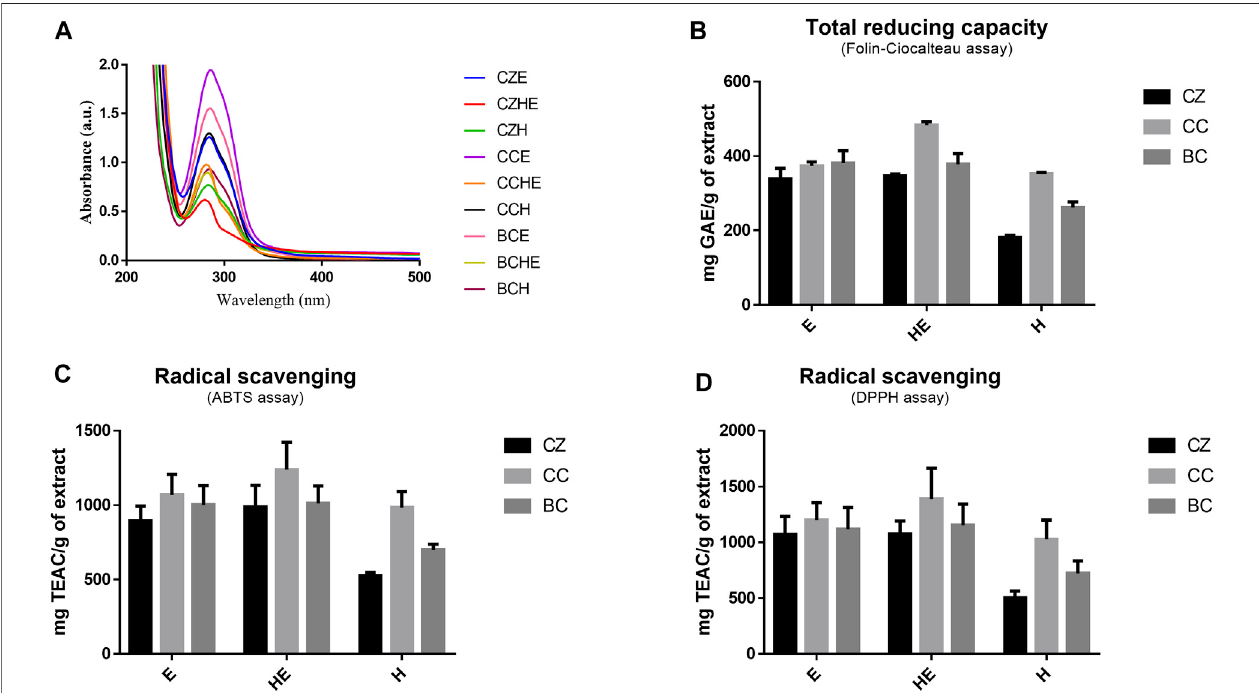
FIGURE 2 | Extract antioxidant activity. UV-Vi ’ s absorption spectra of cinnamon extracts dissolved at 50 μ g/ml in MilliQ water (A) . Total reducing capacity (or total polyphenolic content) was assessed by Folin – Ciocalteau ’ s assay (B) and radical scavenging capability was assessed by ABTS and DPPH assays (C,D) . Total reducing capability results are expressed as mg of GAE equivalents per g of freeze-dried cinnamon extracts and radical scavenging results are expressed as mg of Trolox equivalents (TE) per g of freeze-dried cinnamon extracts. All data are reported as mean ± SD of triplicate measurements in three independent experiments. BC: Cinnamomum cassia buds; CC: Cinnamomum cassia bark; CZ: Cinnamomum zeylanicum bark (CZ); E: alcoholic extraction in ethanol; HE: hydroalcoholic extraction in water (pH 4.5)/ethanol 7:3; H: aqueous extraction.